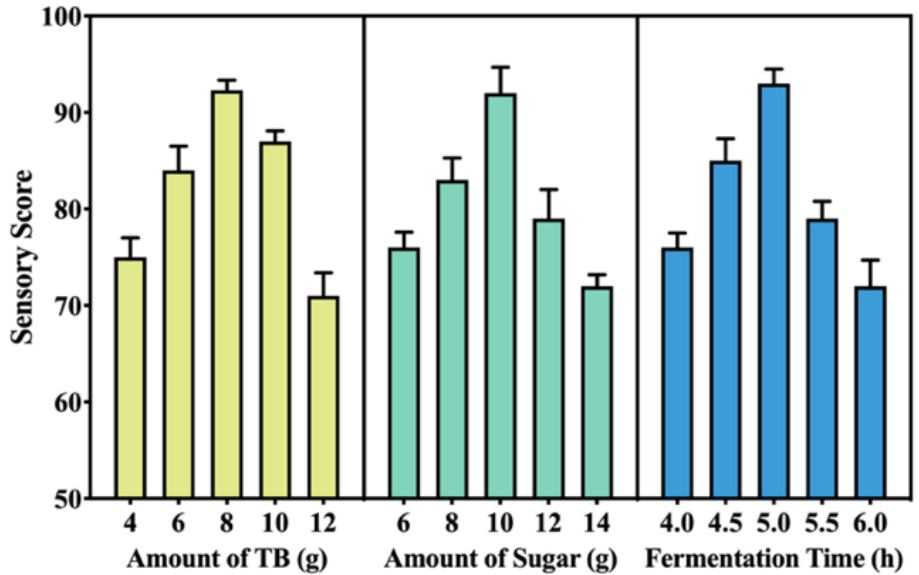
Figure 2. The sensory evaluations of prepared yogurt under different conditions.